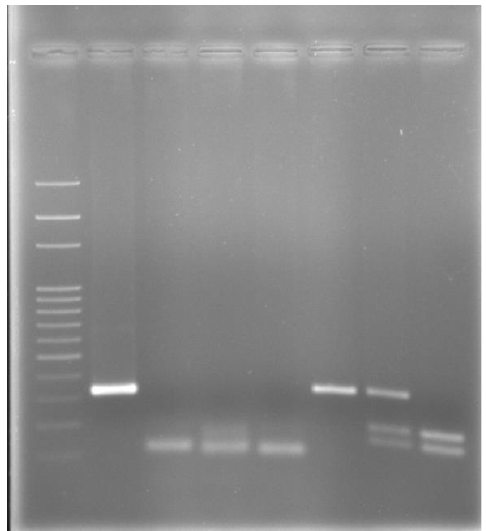
Figure 1. Electrophoresis after MC1R and ASIP amplification/genotyping in a 2% agarose gel: lane 1: 100-bp Ladder; lane 2: amplified MC1R Exon-1 fragment of 317-bp in length; lane 3: A/A ho- mozygous dominant genotype without 11-bp deletion in any allele (102-bp band only); lane 4: A/a heterozygous genotype with 11-bp deletion in only one allele (102 + 91-bp bands); lane 5: a/a ho- mozygous recessive genotype with 11-bp deletion in both the alleles (91-bp band only); lane 6: E/E or C/C dominant homozygous genotype (317-bp band only); lane 7: E/e or C/T heterozygous genotype (317 + 180 + 137-bp bands); lane 8: e/e or T/T recessive homozygous genotype (180 + 137-bp